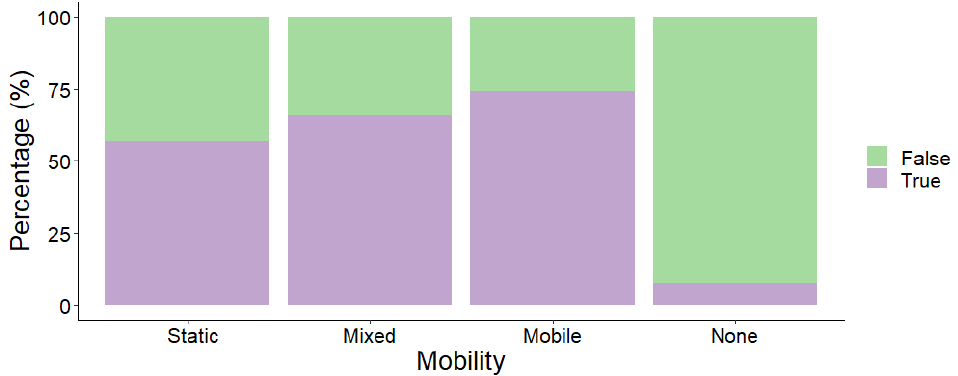
Figure 26. Deployment distribution between node mobility and existence of a goal